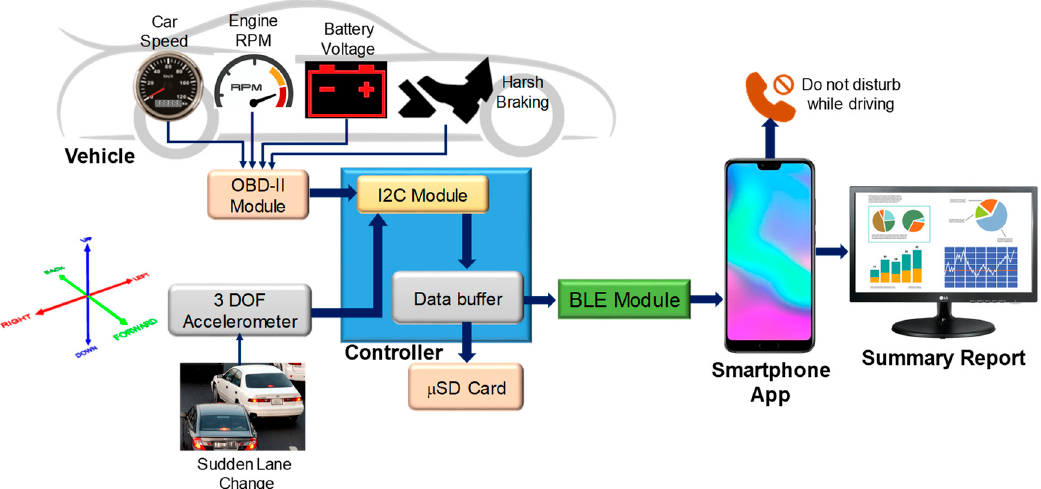
Figure 1. Complete system block diagram.